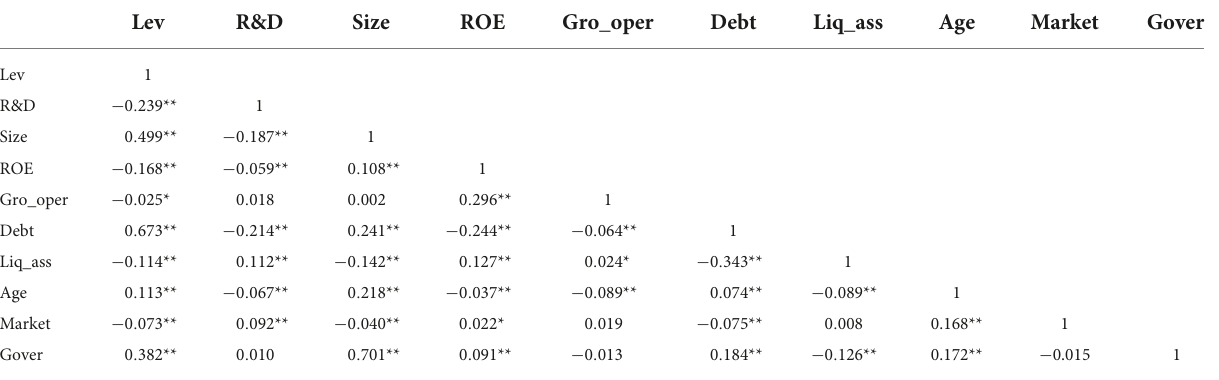
TABLE 3 Pearson correlation coefficients of the variables.